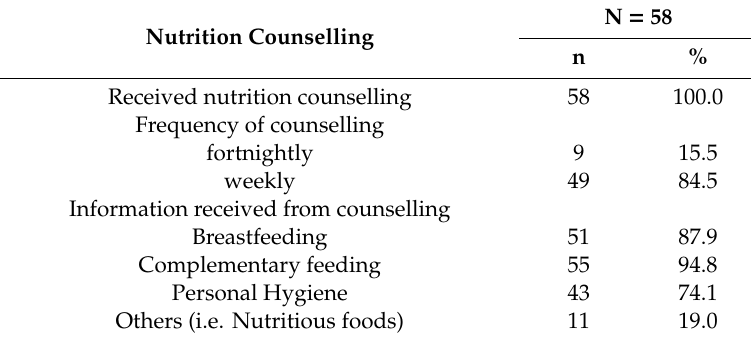
Table 4. Feasibility of nutrition counselling.